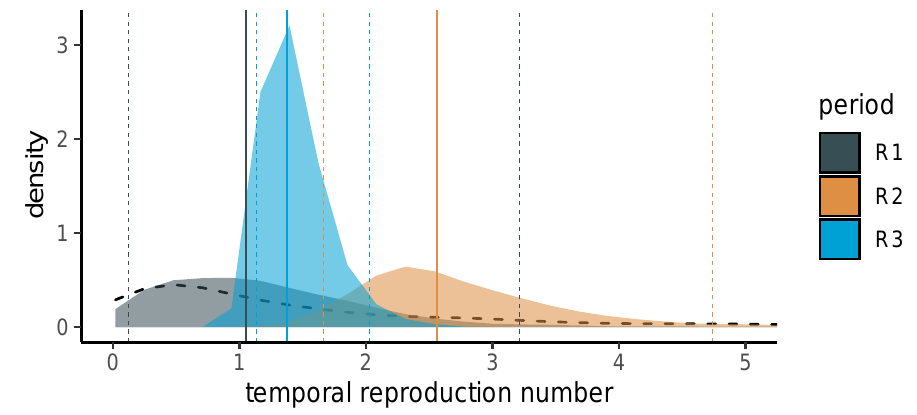
Figure 5 – Temporal reproduction numbers inferred using the BDSKY model. These re- sults are obtained for the France186 dataset. The black dashed curve show the prior distribution, and the posterior distributions are in color. Vertical plain lines show distri- bution medians, while vertical dashed lines indicate the 95% highest posterior density